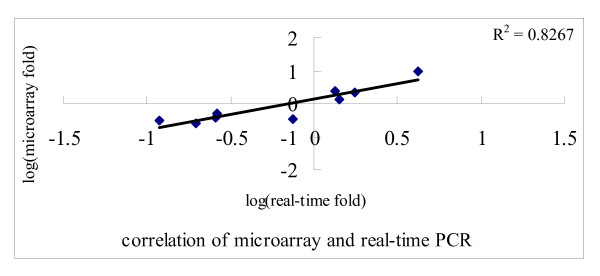
Comparison of transcription measurements by microarray and real-time PCR assays. The relative transcriptional levels for the 9 genes listed in Figure 1 were determined by microarray and real-time RT-PCR. The real-time RT-PCR log2 values were plotted against the microarray data log2 values. The correlation coefficient (R2) between the two datasets is 0.8267.